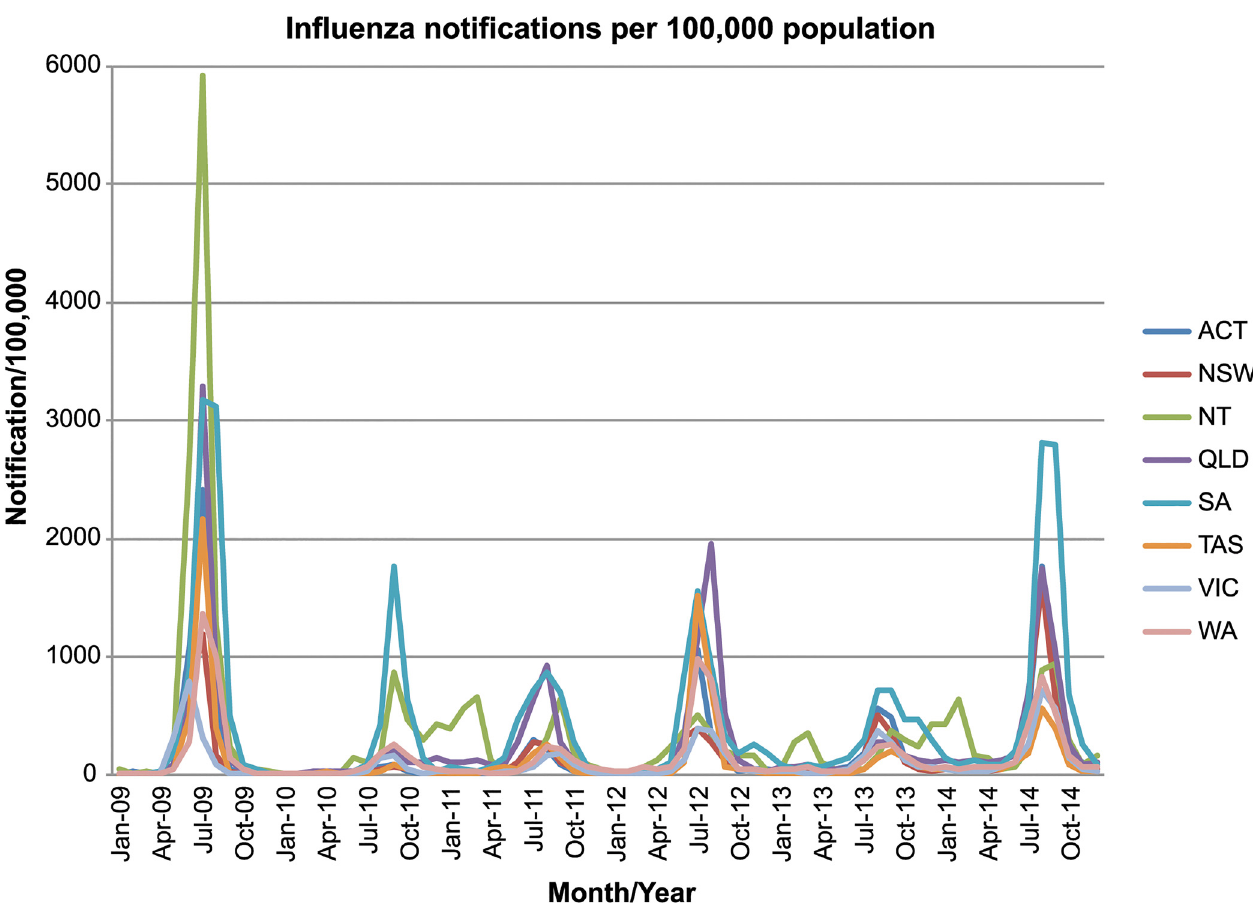
Fig 4. NNDSS influenza notifications in Australia. Laboratory-confirmed influenza notifications throughout the seasonal and inter-seasonal period in Australia. The plot shows laboratory-confirmed diagnoses per 100,000 population from 2009 – 2014, with states and territories displayed separately. Data